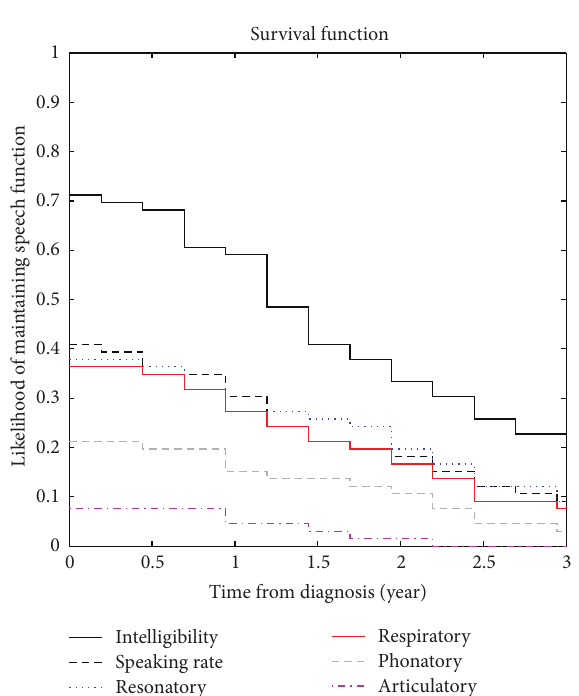
Figure 3: Survival functions for speech intelligibility (black solid), speaking rate (black dashed), respiratory (red solid), phonatory (grey dashed), articulatory (magenta dash-dotted), and resonatory (blue dotted) subsystem